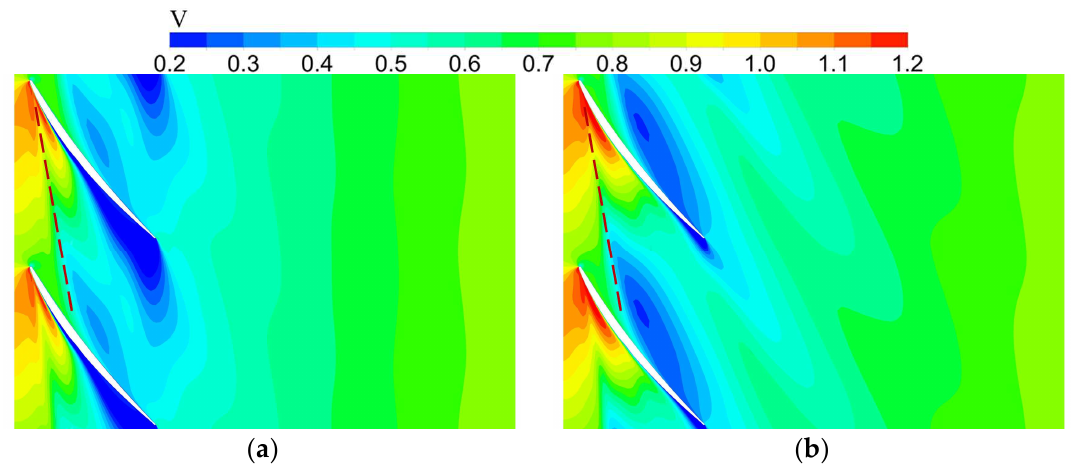
Figure 19. Distribution of time-averaged relative velocity and the line of wake and TCV interaction at 99% span. ( a ) Re = 1 × 10 5 ; ( b ) Re = 4 × 10 5 .